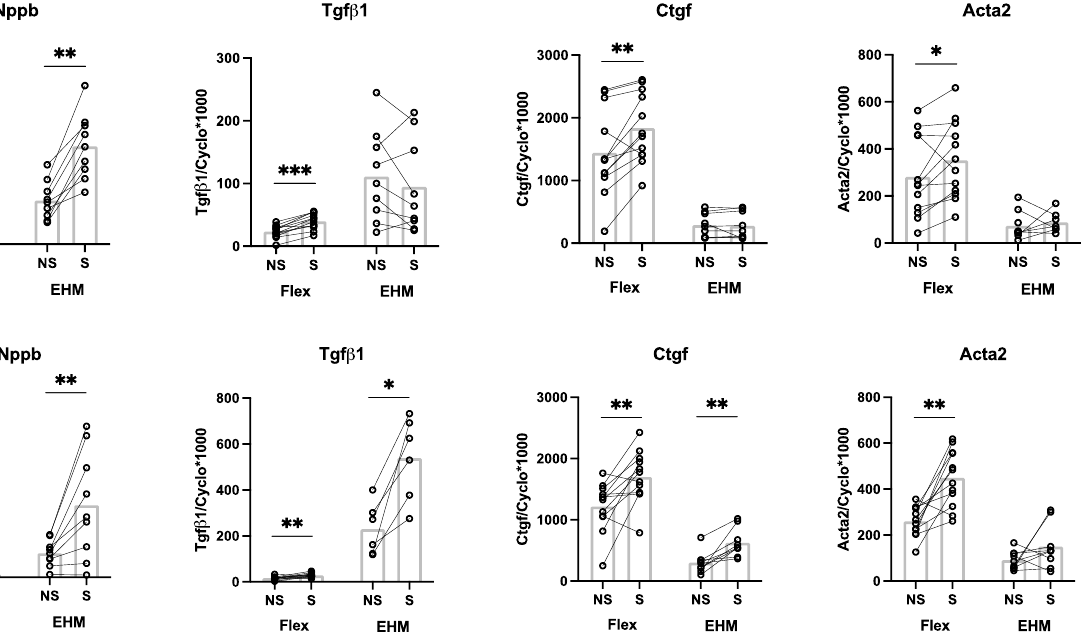
Figure 7. The effect of 4 h ( A ); and 24 h ( B ) cyclic stretch (10%, 1 Hz) on gene expression in CF cultured on 2D monolayer Bioflex plates (Flex) (data from [32]) or 3D EHM fibers (EHM) conditions. Presented are the relative gene expression levels of Nppb, Tgf β 1, Ctgf and Acta2 in 2D ( n = 5–12) and 3D ( n = 6–9) in stretch (S) and non-stretch (NS) conditions. * p < 0.05; ** p < 0.01; *** p < 0.001. Bar indicates mean.